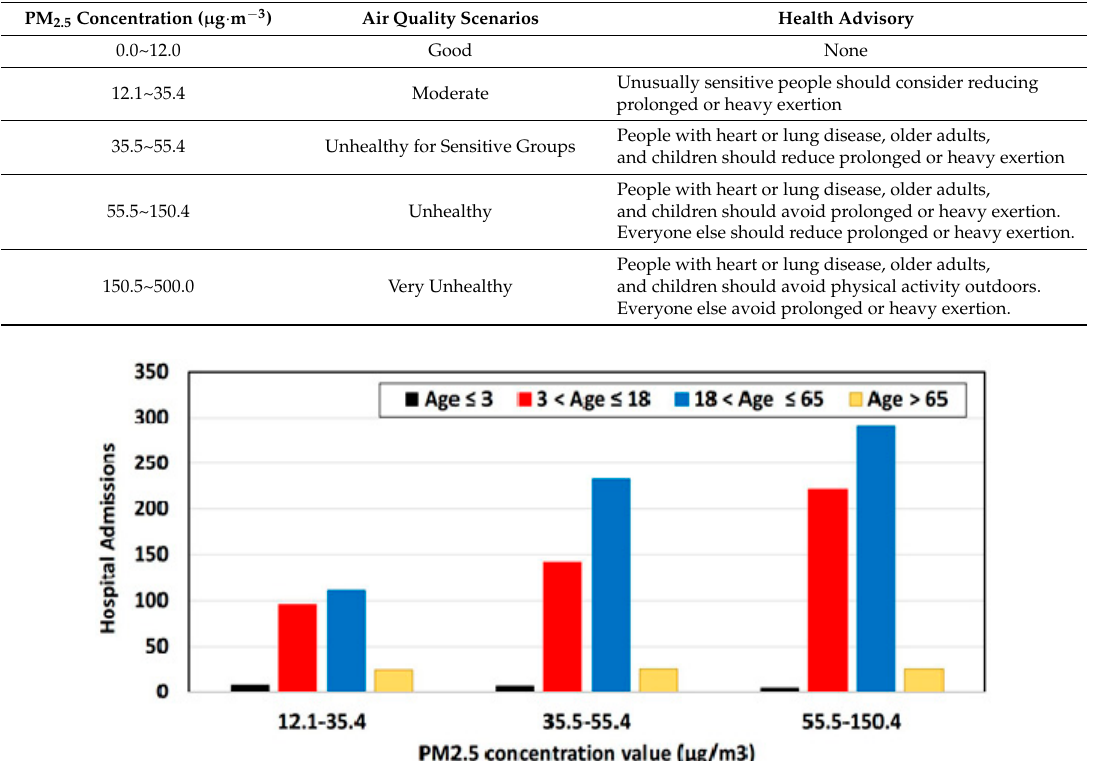
Figure 6. Bar graph of hospital admissions for four age groups against the PM 2.5 level under three air quality scenarios. The lower and upper limits of these three scenarios are based on the United States Environmental Protection Agency (US/EPA) health advisory in Table 3.